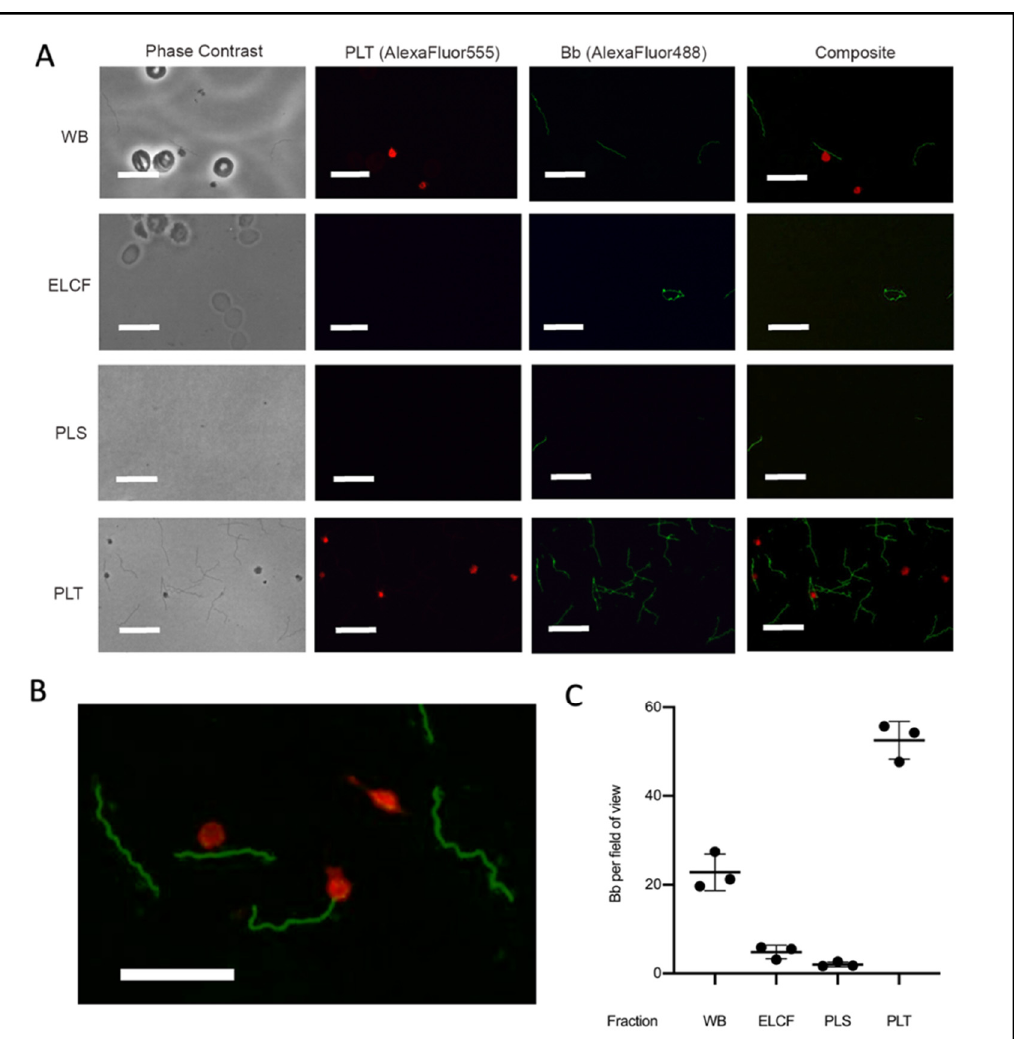
Figure 5. Microscopy of experimentally infected blood before and after fractionation. ( A ) Representative immunofluorescent micrographs of Borrelia (green) in fractions collected from experimentally infected whole blood (platelets labelled red). Scale bar = 13 μ m. ( B ) Magnification of PLT fraction composite demonstrating co-localization. Scale bar = 13 μ m. ( C ) Corresponding quantification of Borrelia per field of view from A; n = 3. All comparisons by ANOVA and Tukey’s multiple comparisons post-hoc test were significant with p < 0.005 except red blood cells and plasma. Data represented as the means with standard deviation. WB = whole blood, ELCF = erythrocyte, leukocyte cellular fraction, PRP = platelet-rich plasma, PLS = plasma (platelet poor), and PLT = platelet fraction.